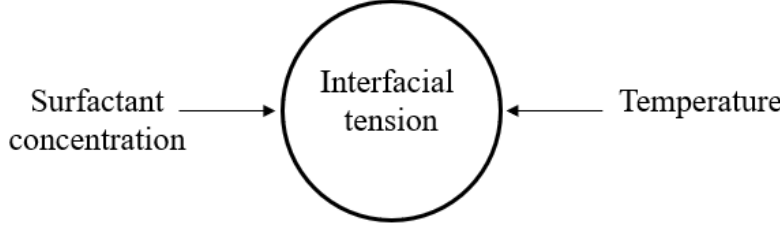
Figure 2. Variables affecting interfacial tension.